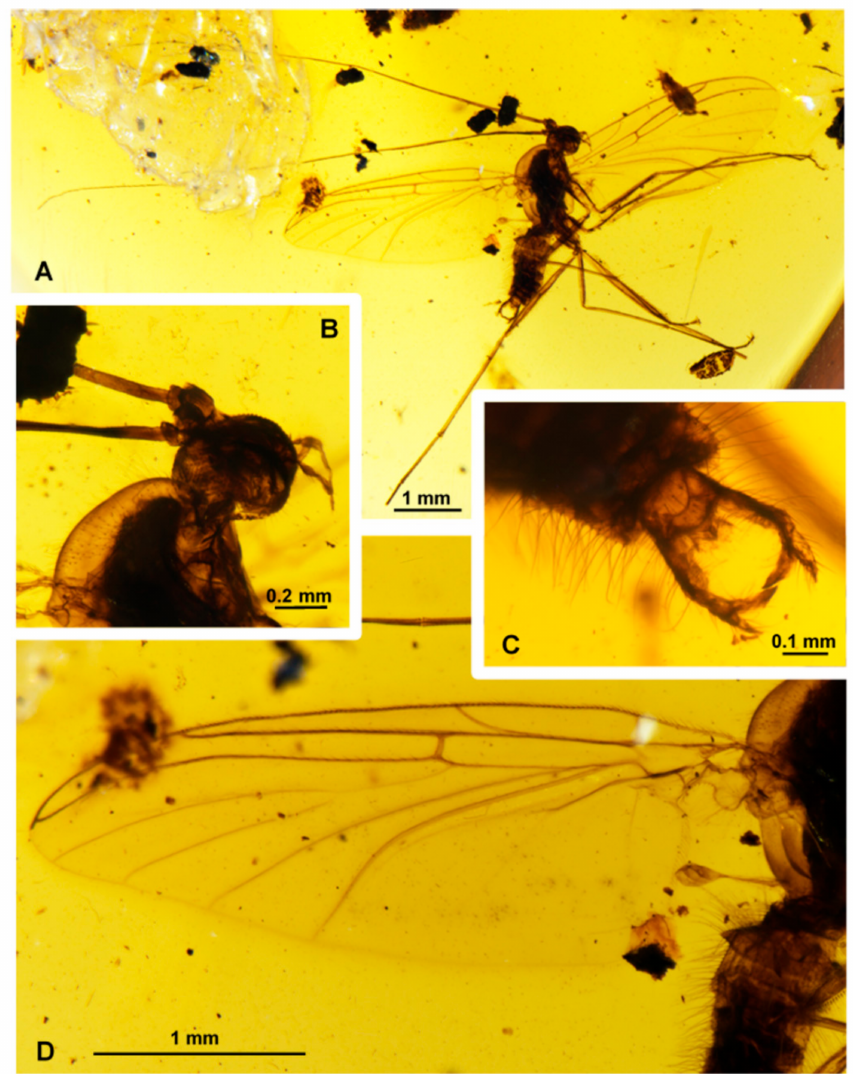
Figure 1. Adamacrocera adami gen. et sp. nov. Photos of the holotype [No. 426 / 2019]. ( A ) Whole specimen; ( B ) head; ( C ) male terminalia; ( D )